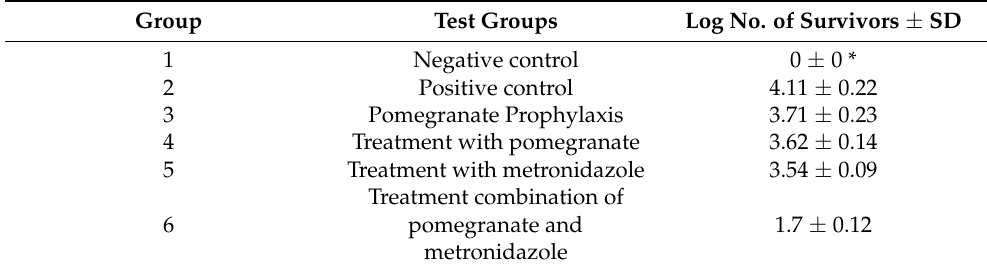
Table 4. The viable count of H. pylori colony forming units (CFU) following subjection of infected rats to different